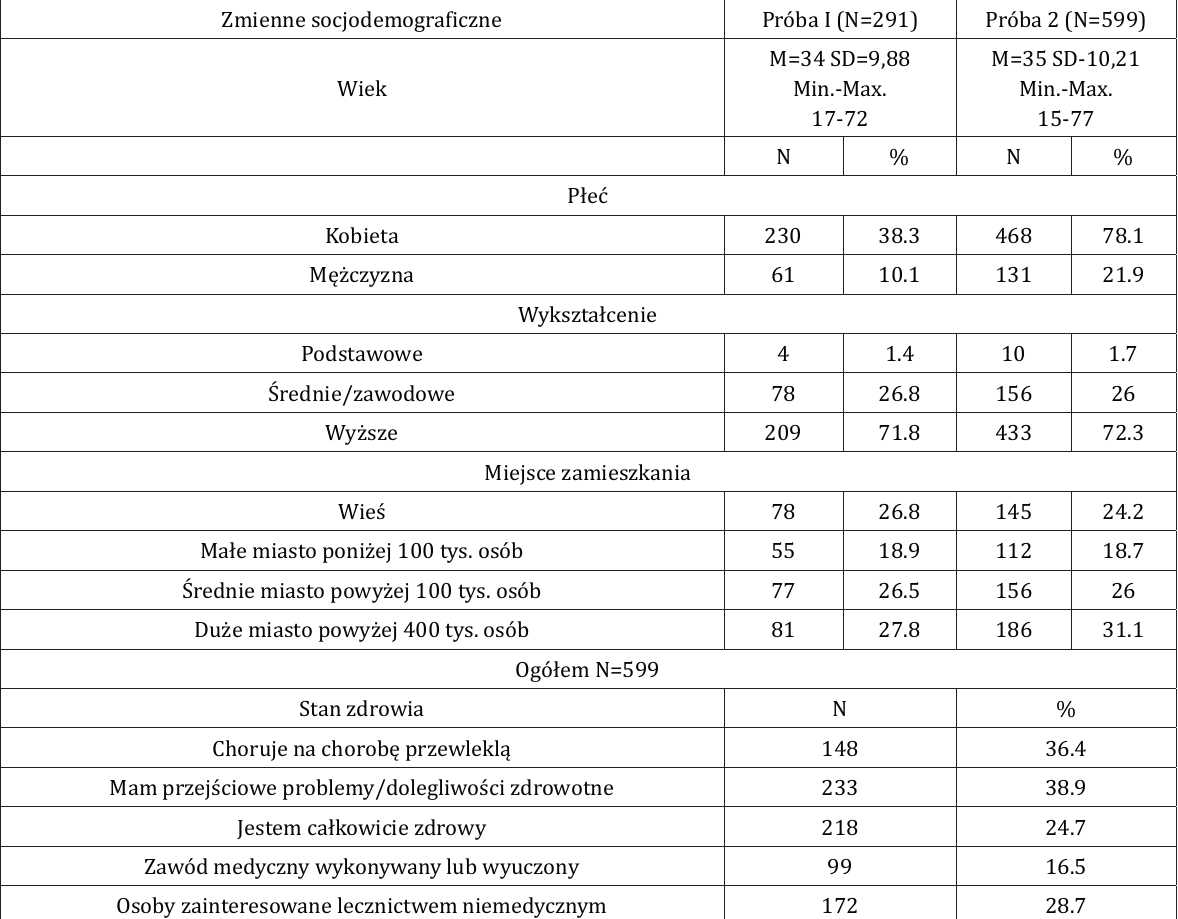
Tabela 1. Charakterystyka badanej